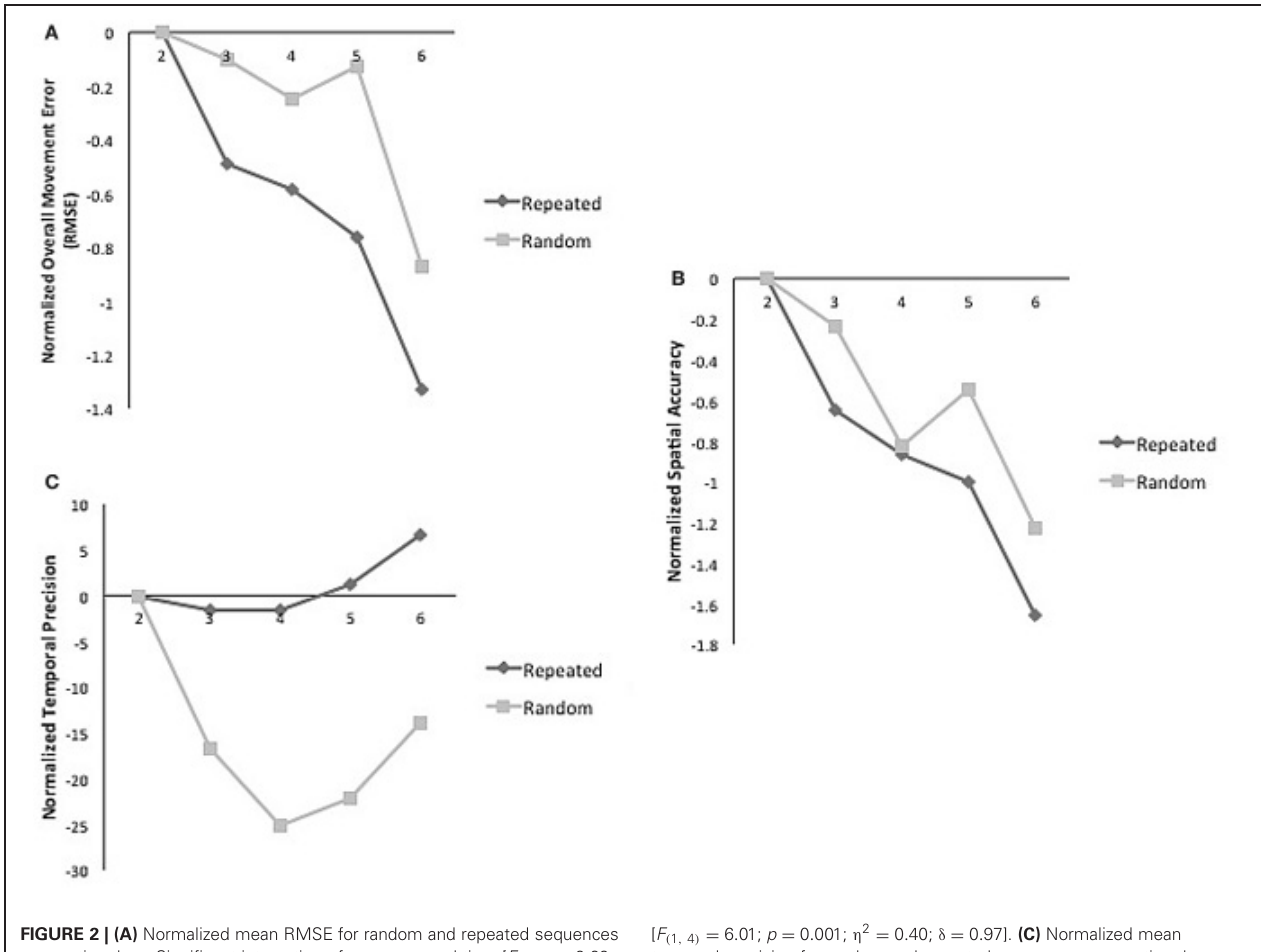
FIGURE 2 | (A) Normalized mean RMSE for random and repeated sequences on practice days. Significant interaction of sequence and time [ F ( 1 , 4 ) = 2 . 62; p = 0 . 05; η 2 = 0 . 22; δ = 0 . 289]. (B) Normalized mean spatial accuracy for random and repeated sequences on practice days; main effect of